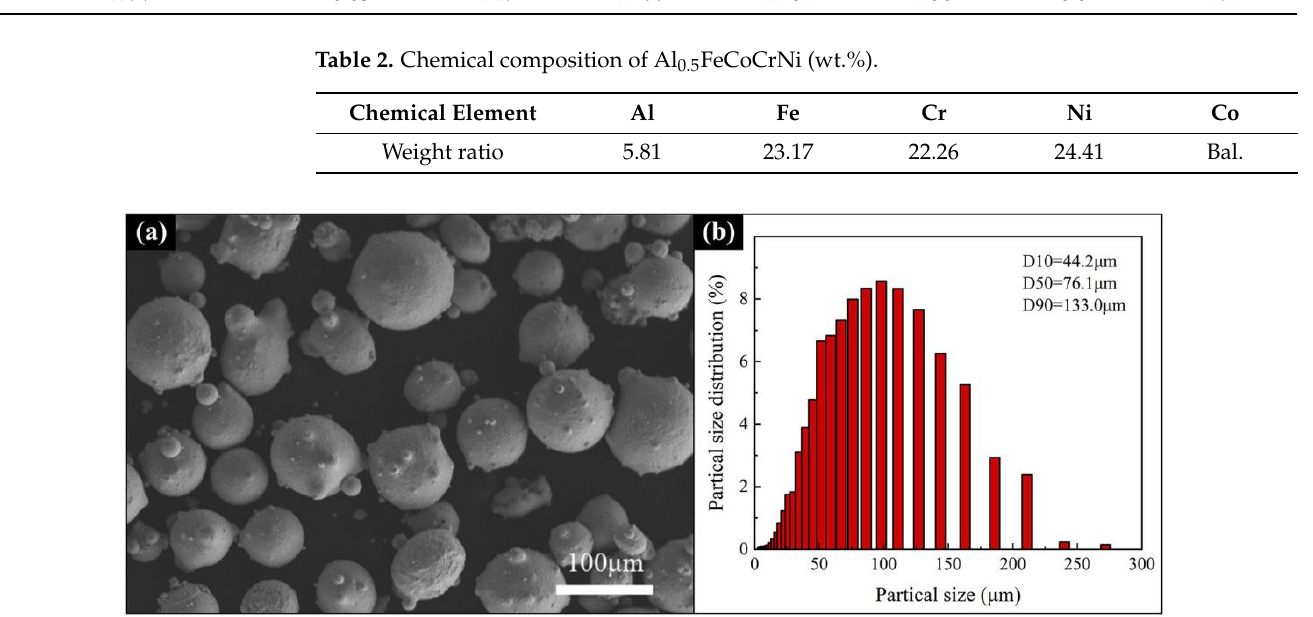
Figure 1. Al 0.5 FeCoCrNi HEA powders: ( a ) SEM microstructure; ( b ) particle size distribution (DX is the particle size when the cumulative distribution is X%).